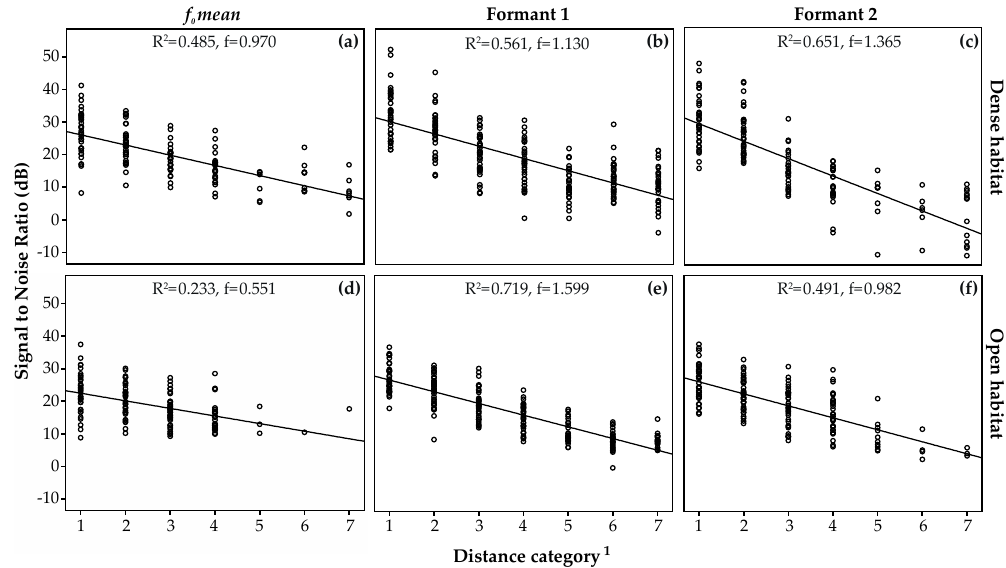
Figure 6. Signal ‐ to ‐ Noise ratio and regression lines for f o mean ( a , d ), Formant 1 ( b , e ), and Formant 2 ( c , f ) per habitat over all recording distances (top three figures represent the densely vegetated and the three bottom figures the open habitat) show formant and f o attenuation with increasing distances. Cohen’s f indicates the effect sizes (f > 0.5 represents a strong effect size). 1 Distance category: 1 = 50 m, 2 = 100 m, 3 = 200 m, 4 = 400 m, 5 = 800 m, 6 = 1000 m, 7 = 1500